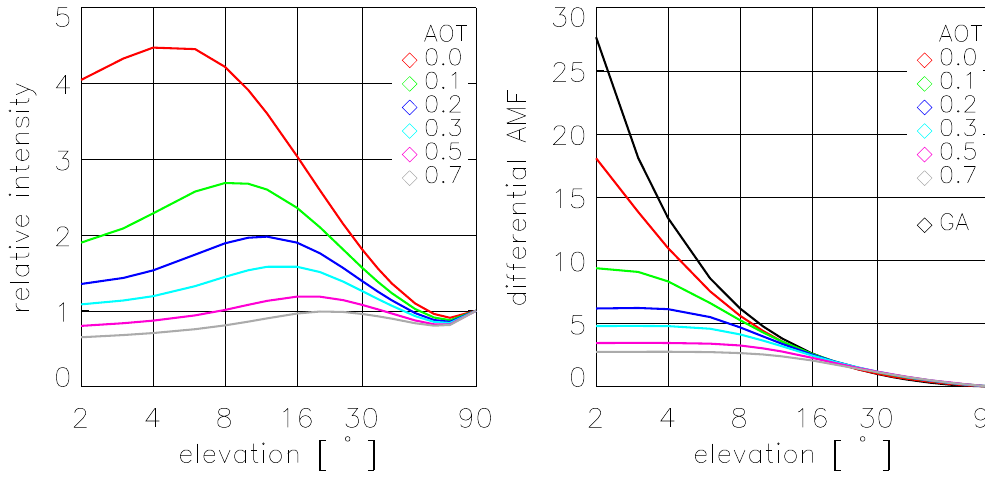
Fig. 7. Radiative transfer simulations with the DAK model of relative intensity (left) and the differential air mass factor of NO 2 (right) at 428.22 nm as a function of the elevation, for different values of the AOT. Note the logarithmic scale on the x-axis. The black line in the right plot gives the differential air mass factor for the geometrical approximation (GA). Solar zenith angle = 50 ◦ , relative azimuth angle = 180 ◦ .